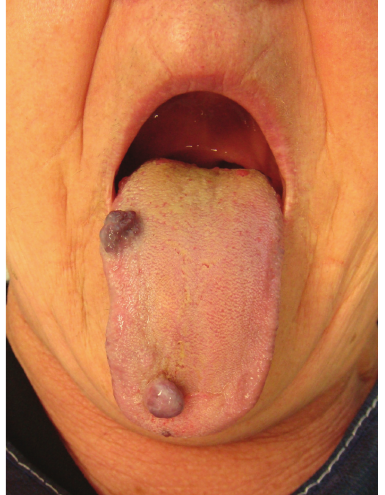
Figure 1: Two soft, dark-red nodules with 12mm × 10 mm suggestive of vascular lesions and a small nodule of 2 × 2mm in the tip of the tongue are present.